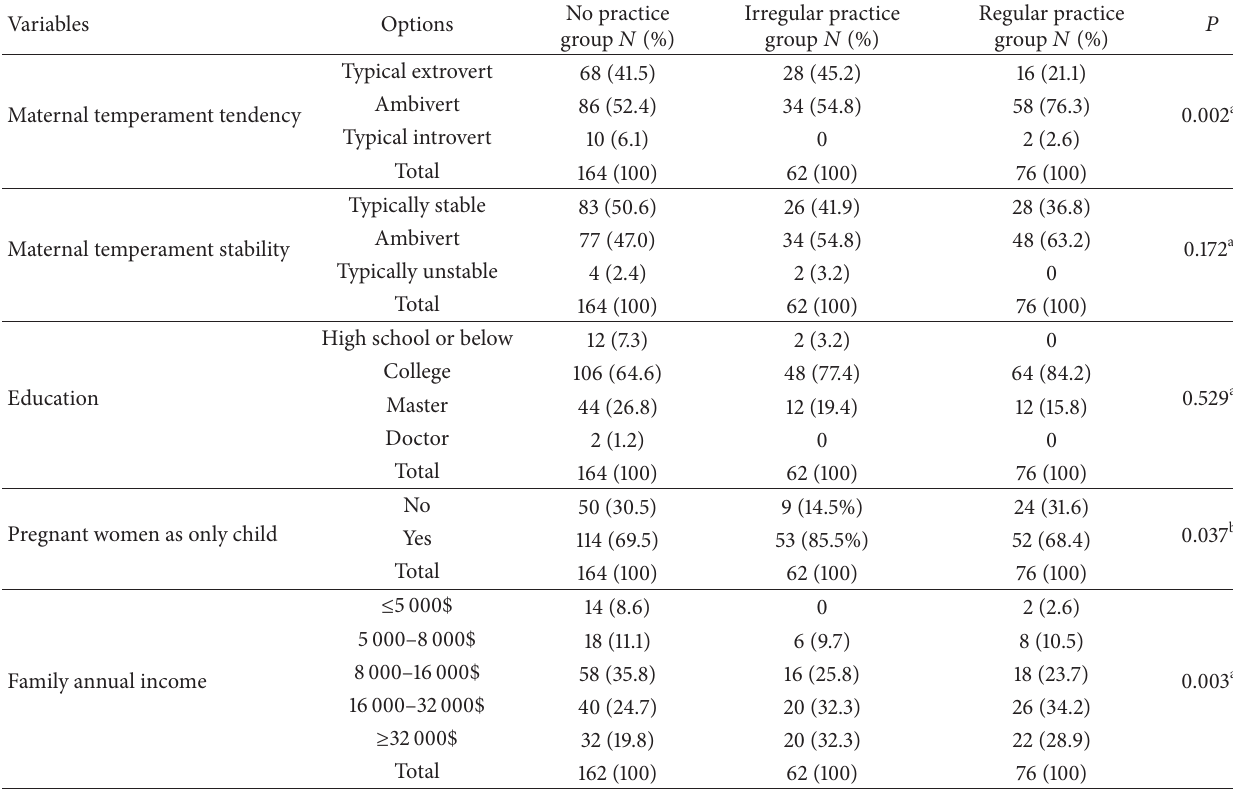
Table 1: The comparison of demographic characteristics among the three